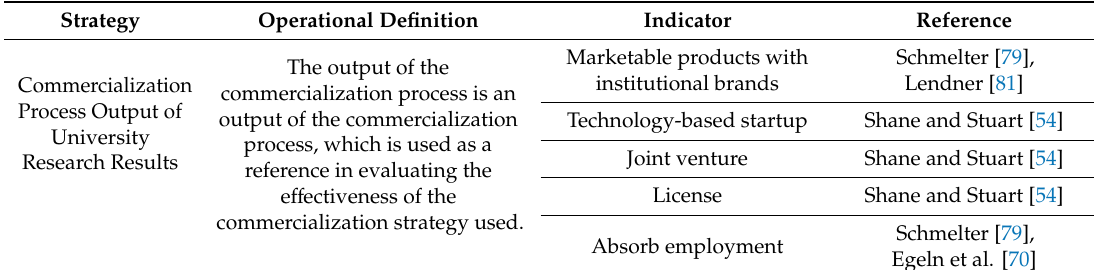
Table 3. Operationalization of output variables and identification of